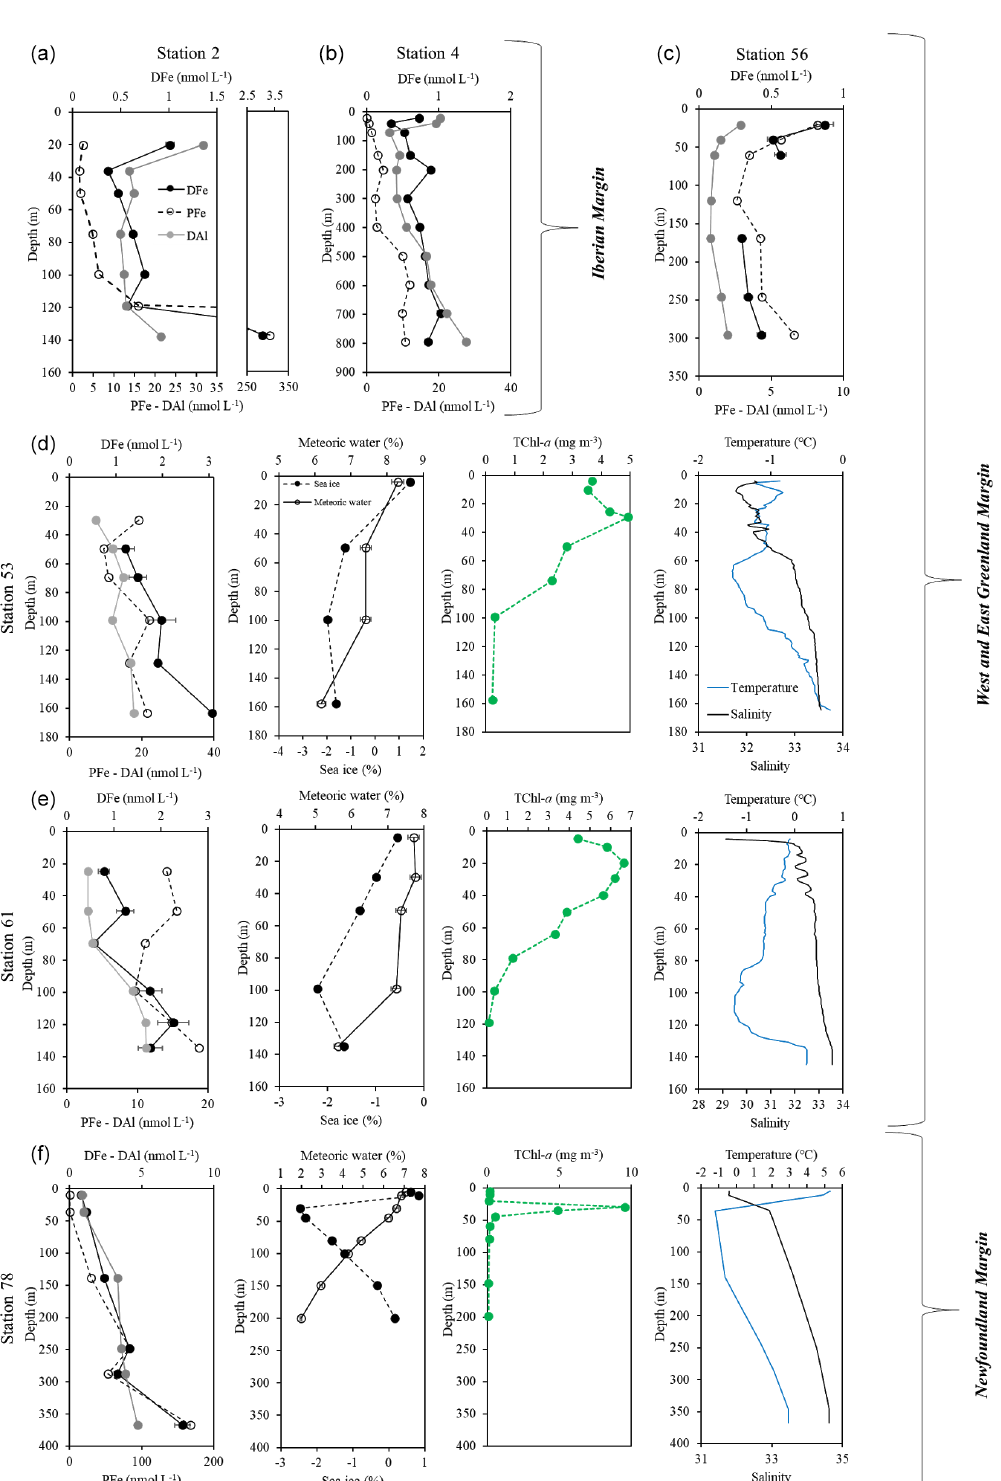
Figure 4. Vertical profiles of dissolved iron (DFe, black dots, solid line), particulate iron (PFe, black open dots, dashed line; Gourain et al., 2019), and dissolved aluminum (DAl, grey dots; Menzel Barraqueta et al., 2018) at stations 2 (a) , and 4 (b) located above the Iberian shelf; station 56 (c) , station (d) 53 and station 61 (e) located above the Greenland shelf; and station 78 (f) located above the Newfoundland shelf. Note that for stations 53, 61, and 78, plots of the percentage of meteoric water (open dots) and sea ice melting (black dots and dashed line) (Benetti et al., 2017, see text for details), total chlorophyll a (TChl a , green), temperature (blue), and salinity (black) are also displayed as a function of